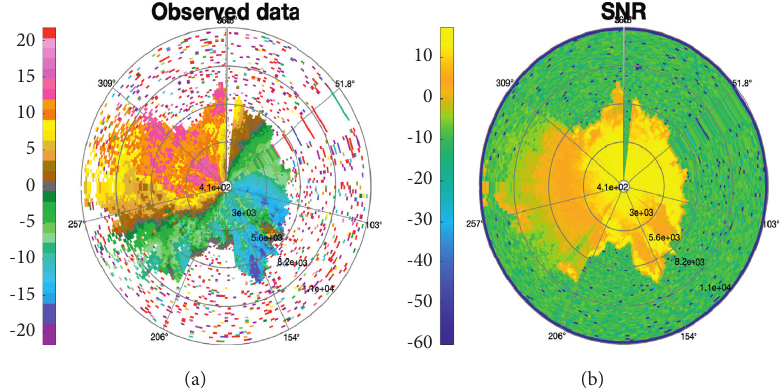
Figure 1: An example of the LiDAR data on 5 March 2015 from 04 :16:02 to 04 :16:25. (a) Wind velocities and (b) signal-to-noise ratio of LiDAR observations. The observations were collected at the Hong Kong International Airport under LiDAR system by Hong Kong Observatory [21,